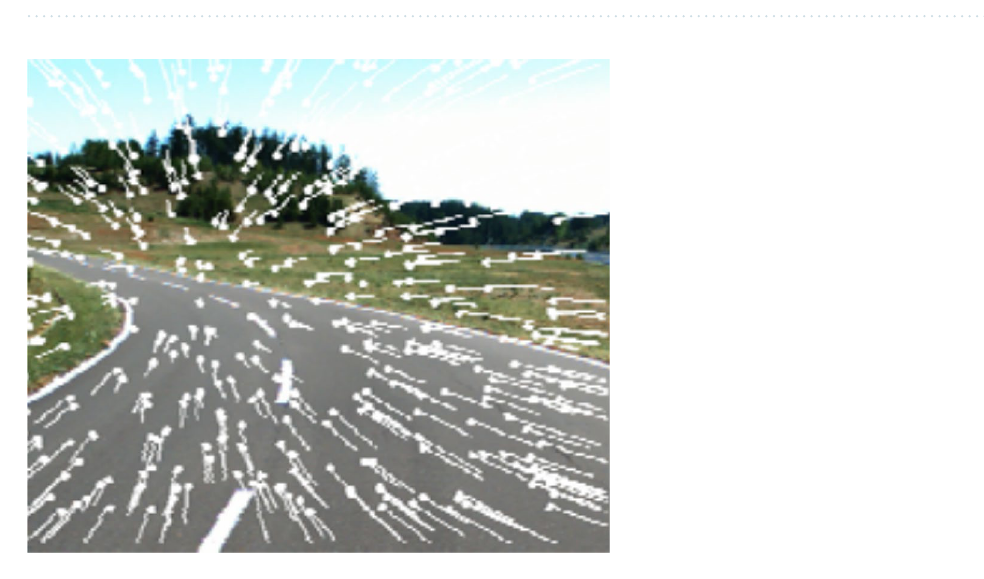
Figure 1. Difference between Tangent Point and Future Path Point. In the right figure, the dot line means an invisible desired path.